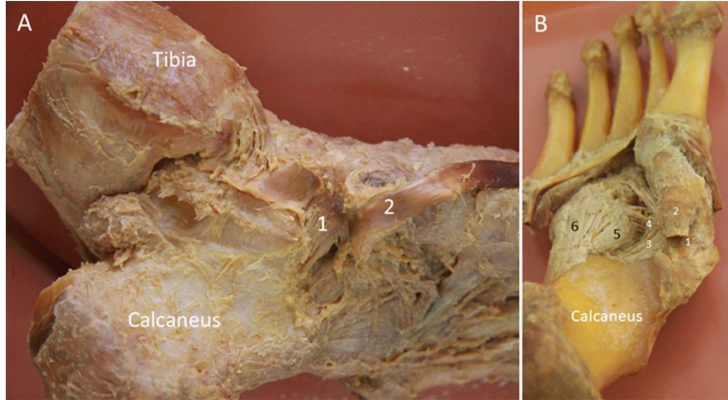
Figure 10. The cadaveric model for the spring ligament viewed from the medial ( A ) and plantar ( B ) aspects. 1: Superomedial component; 2: tibialis posterior tendon; 3: medioplantar component; 4: inferoplantar component; 5: short plantar ligament; 6: long plantar ligament.